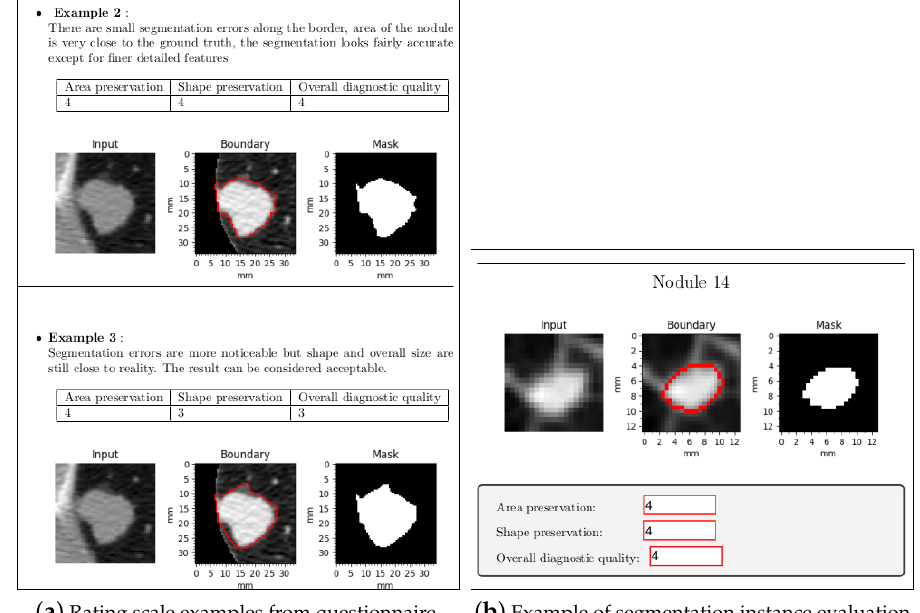
Figure 12. Excerpts from the questionnaire part